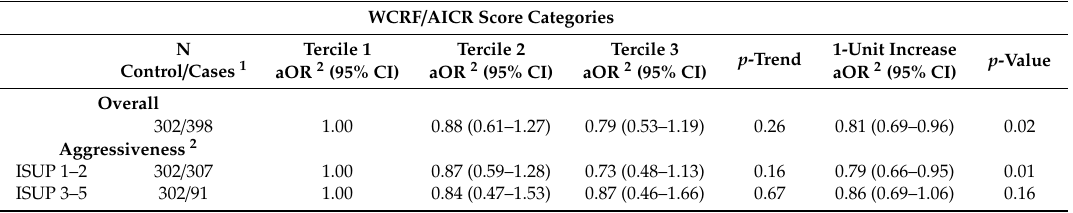
Table 4. Association between 2018 WCRF / AICR score and PCa stratified by aggressiveness in CAPLIFE study.